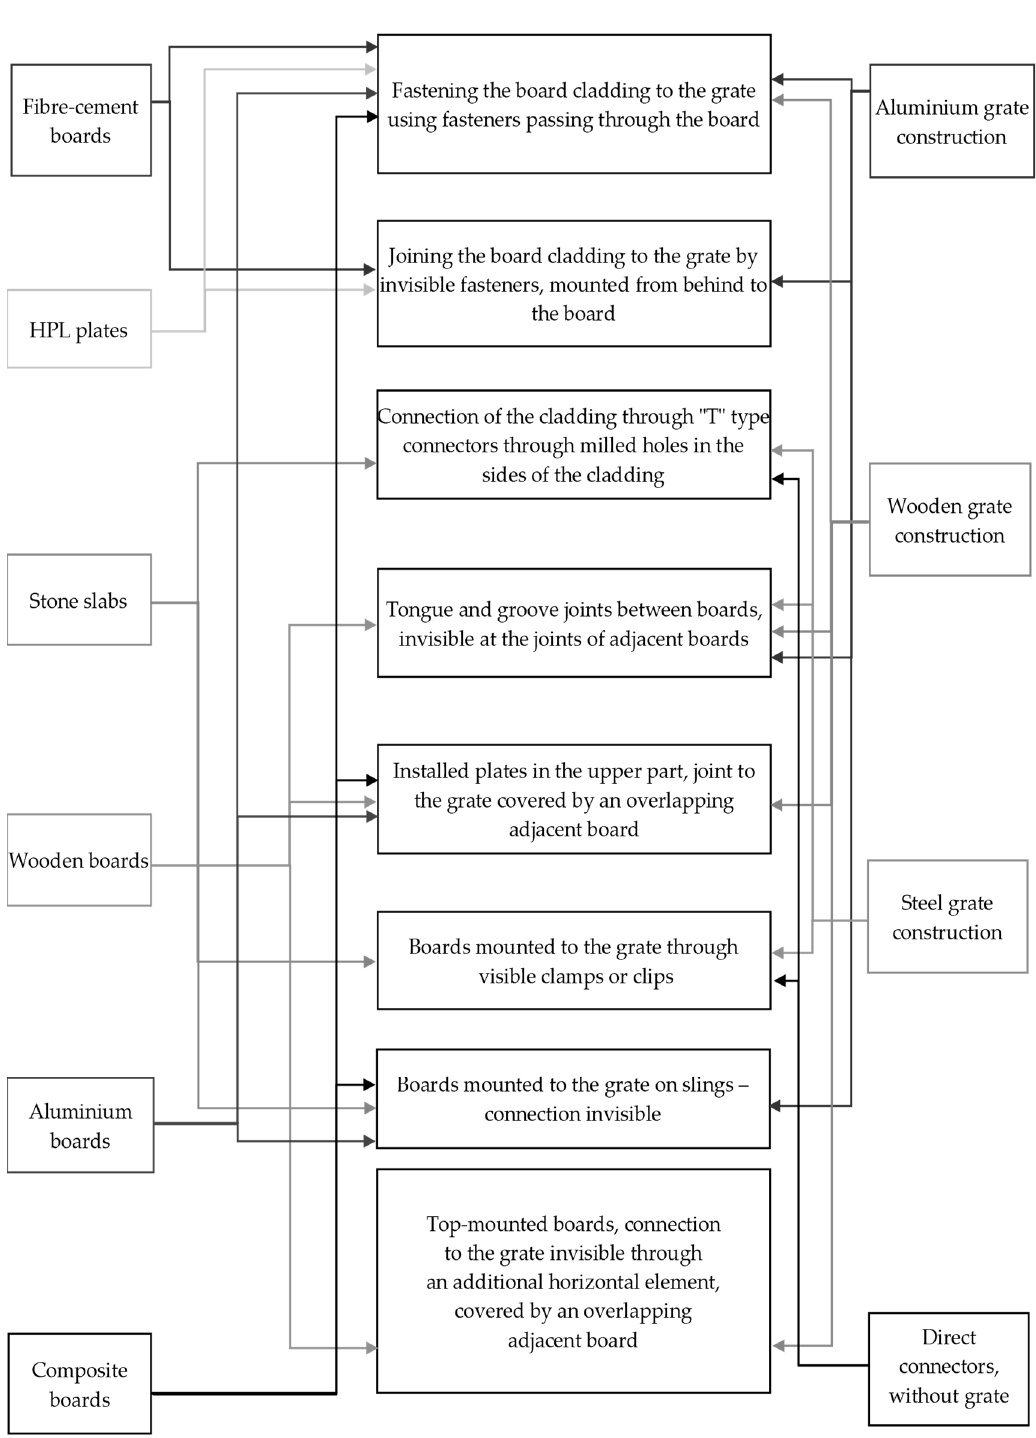
Figure 2. Classification of ventilated facades, according to the material of the external panel and the method of installation. Own study based on [8]. method of installation. Own study based on